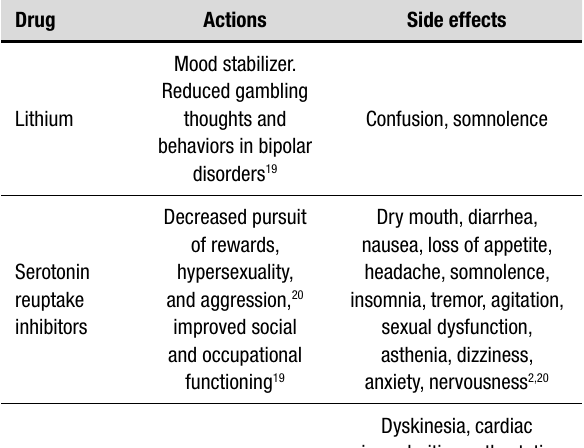
Table 1. Actions and side effects of the main drugs cited in this